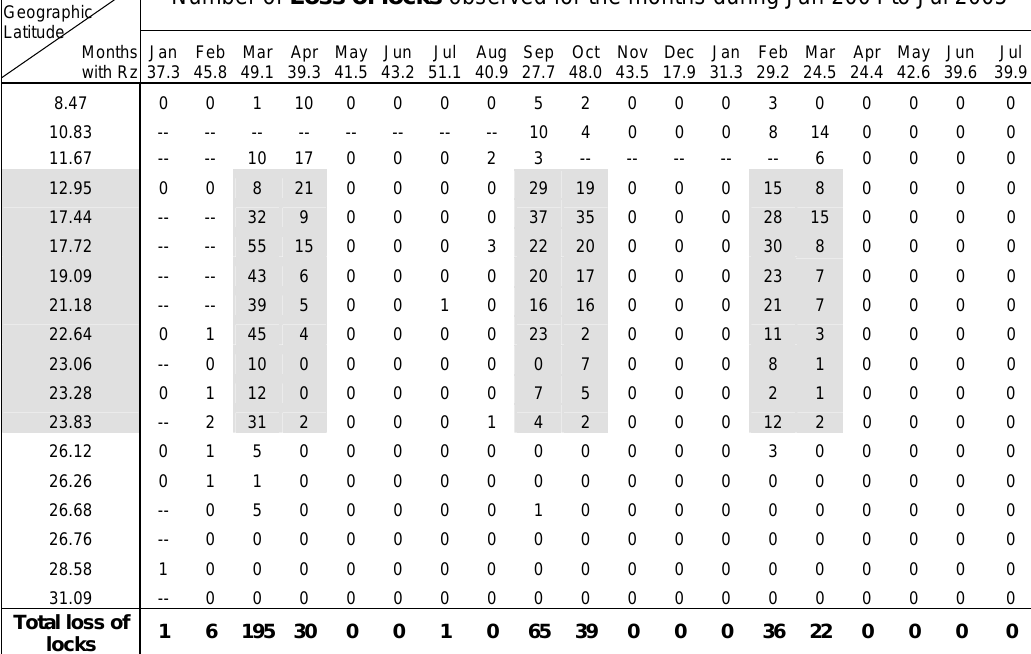
Table 2. Number of loss of lock events observed from each station (latitudes of each station tabulated) for every month during the period from January 2004 to February 2005. The monthly mean sunspot numbers are also shown under each of the